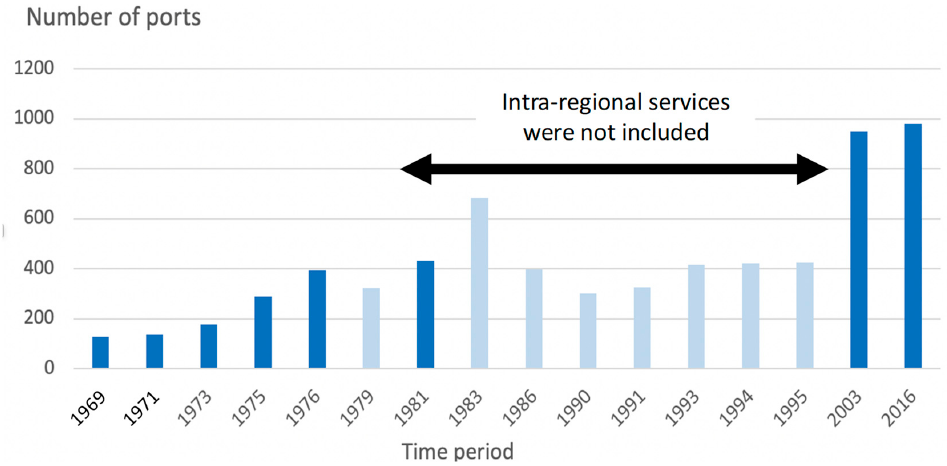
Figure 2. Number of container ports included in the data at each selected time point.